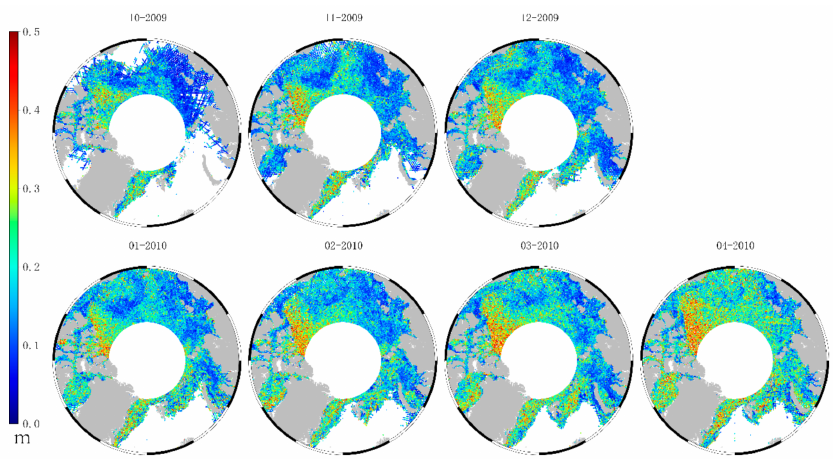
Figure 6. The sea ice freeboard distribution for the 2009/2010 Arctic sea ice growth season from October to April.